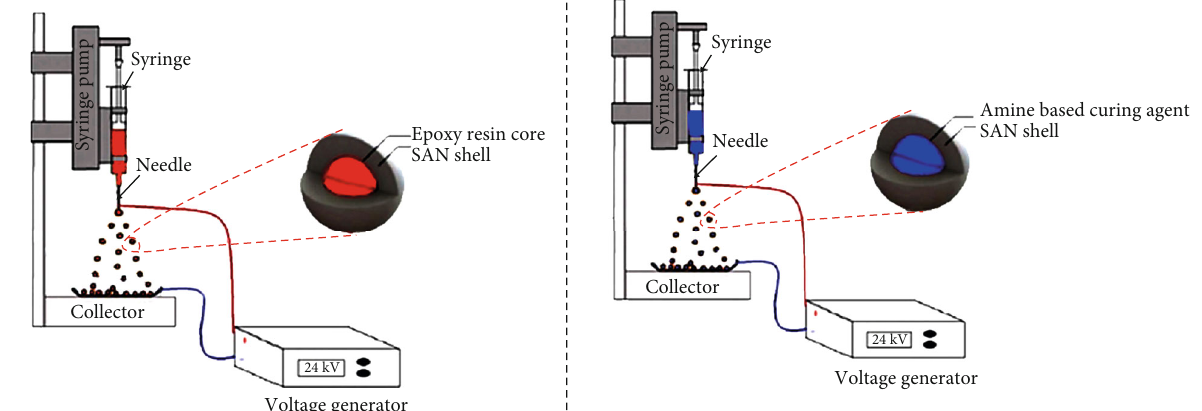
Figure 1: The schematic fi gure of employed electrospray set up to separately encapsulate epoxy and amine-based curing agent within SAN